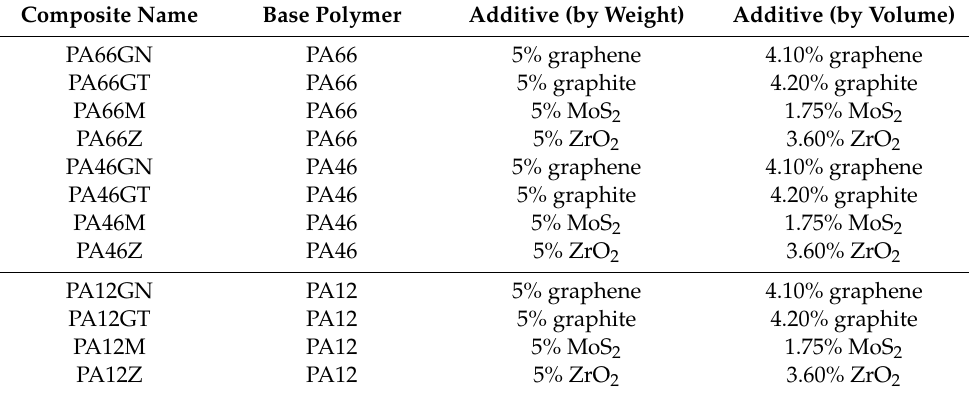
Table 1. Hybrid composites